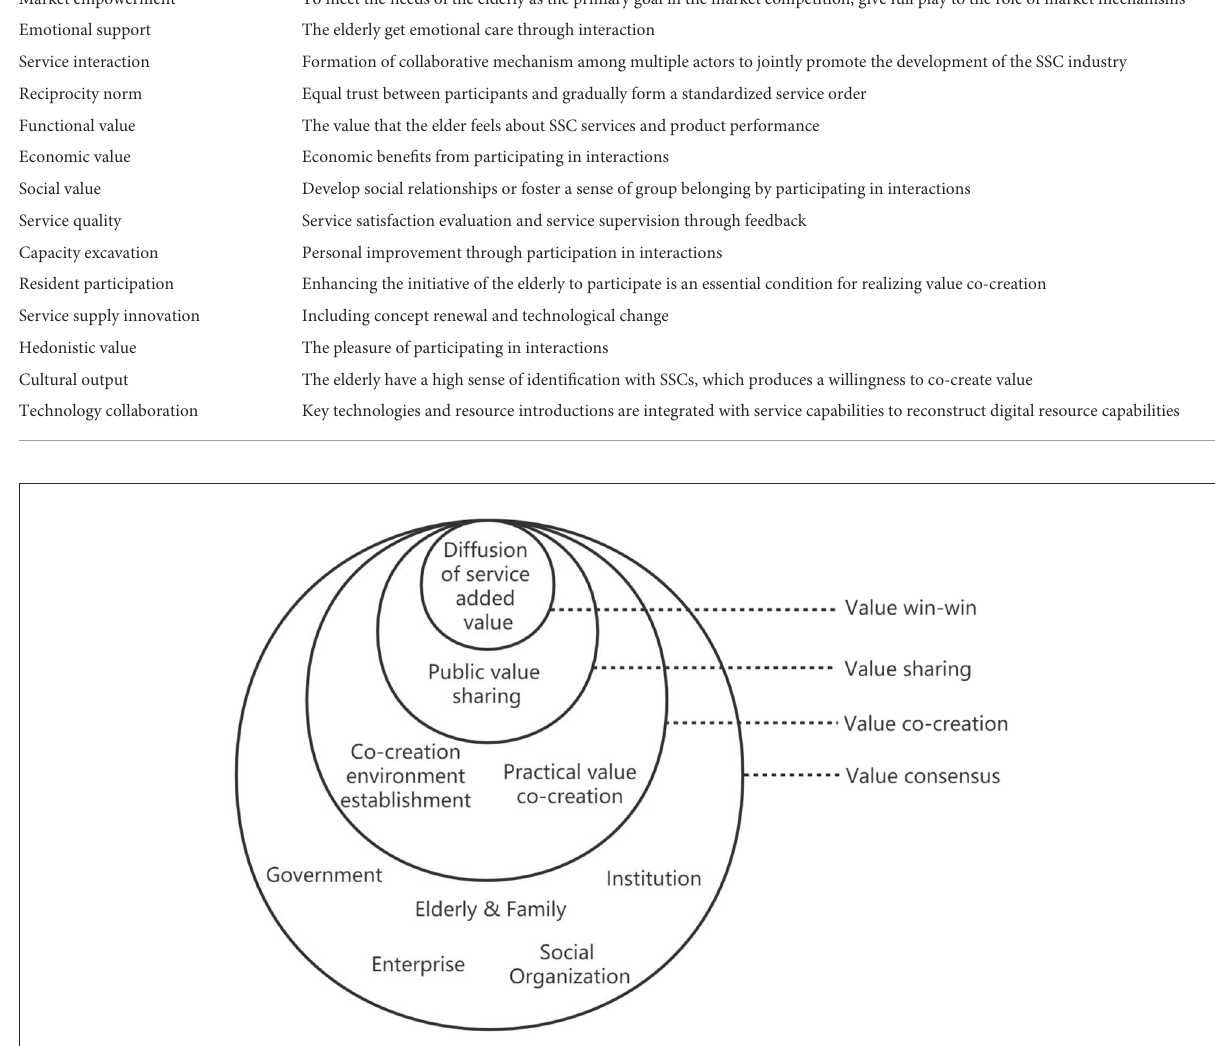
“In order to achieve full institutional coverage, SSC service centers are established in county towns, and home- based SSC service stations are established in townships.” (H, Location